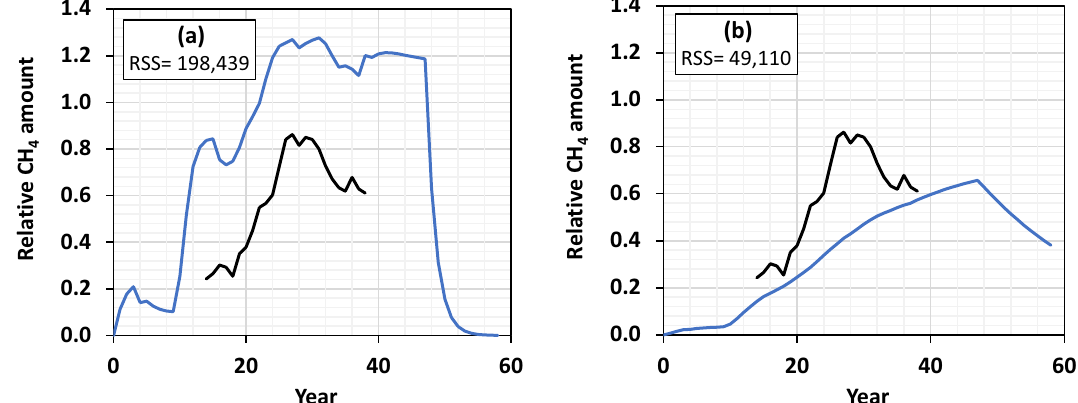
Fig. 2 Benchmark CH 4 modeling using k CH 4 and L 0 of a Nikkhah et al. (2018) and b Ramprasad et al., (2022) in relative values due to data confidentiality (black line is measured and blue line is